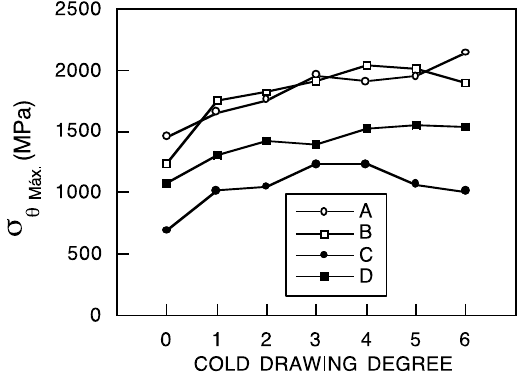
Figure 13. Maximum values of hoop stress.